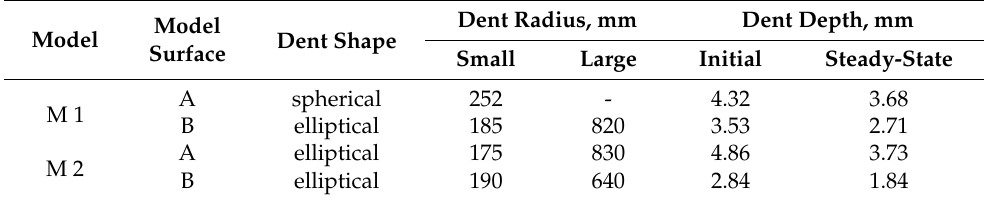
Figure 2. Layout of load cells in the zone of spherical ( a ) and ellipsoidal dents ( b ). The main geometric dimensions of the dents on the model wall are presented in Table 1. Table 1. The shape and geometric dimensions of dents in the model body [33,34].